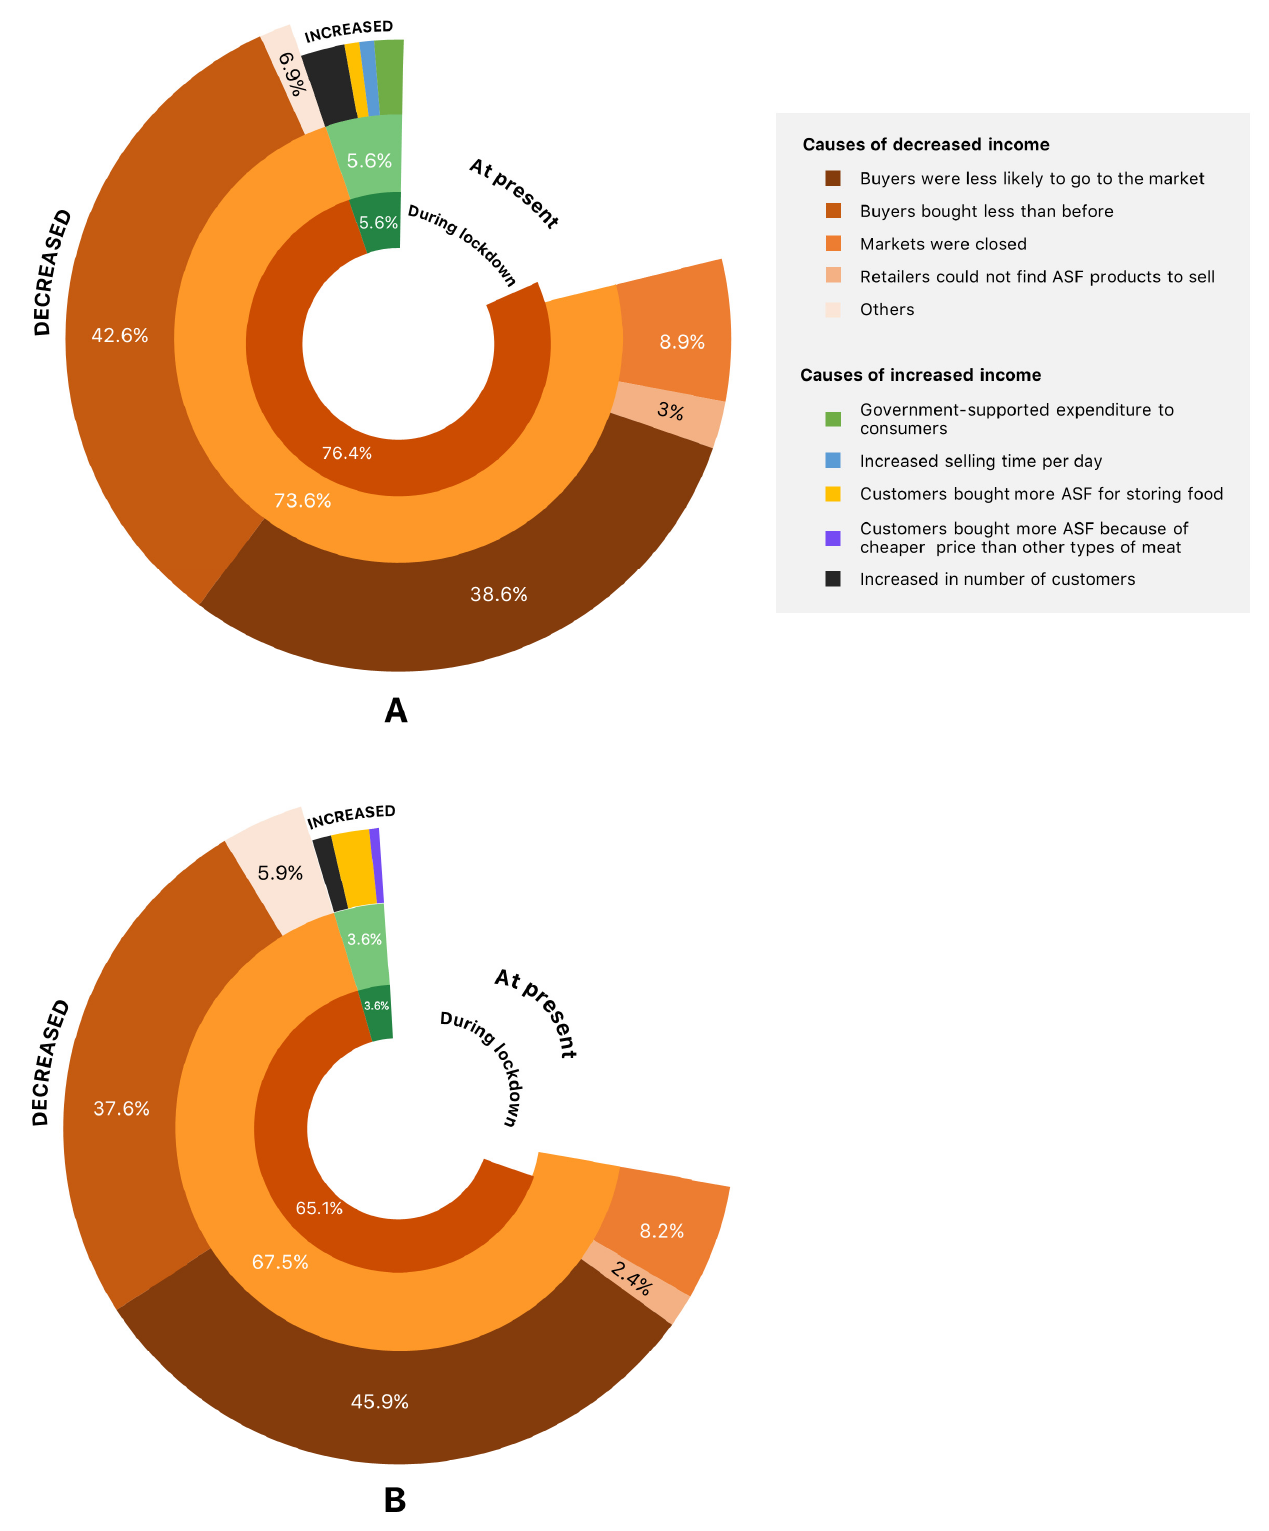
Figure 2. Impacts of COVID-19 on ASF selling income of the retailers in ( A ) U/PU and ( B ) rural areas. The outermost chart details the factors that contributed to decreased/increased income, and the percentage for each item was computed using only retailers that were affected by the COVID-19 pandemic (100% in total).